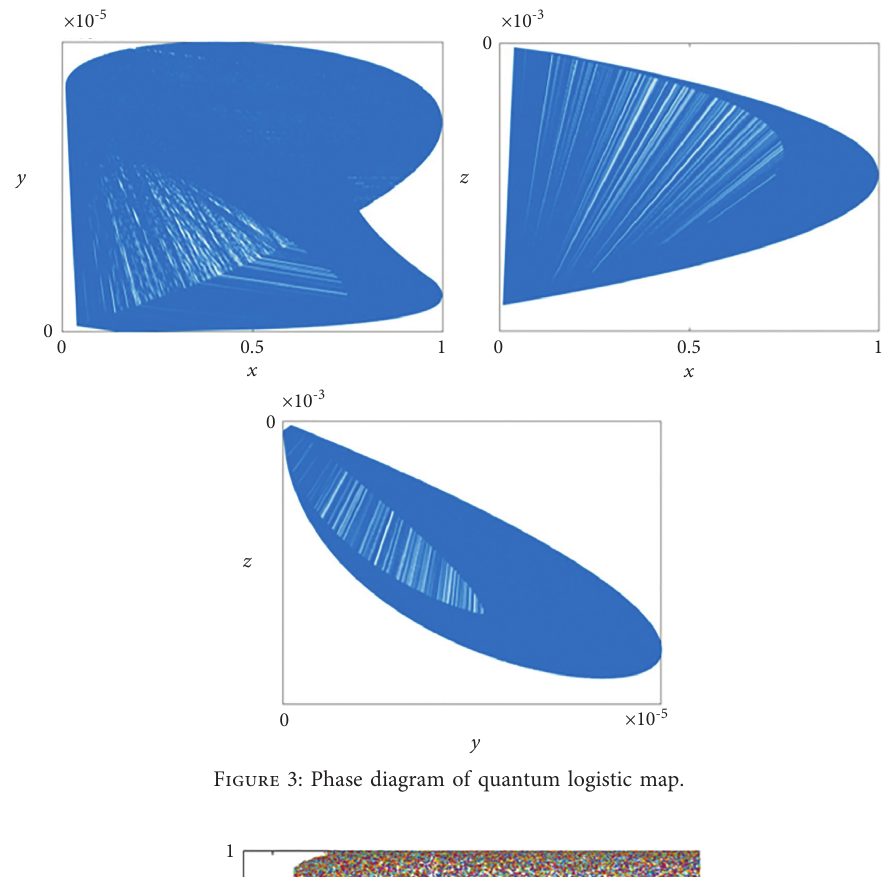
Figure 3: Phase diagram of quantum logistic map.